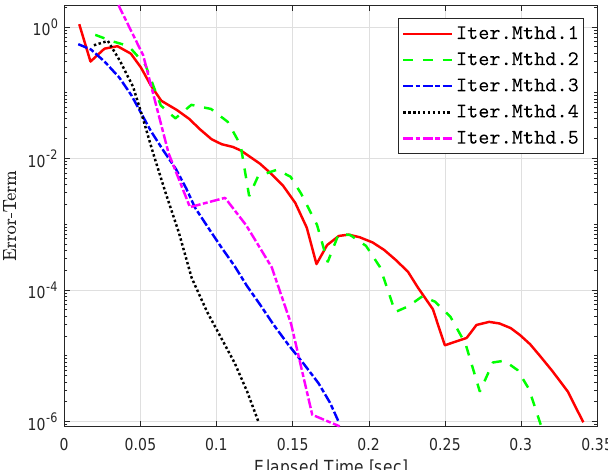
Figure 10. All techniques are computationally examined while s 0 = ( 1, − 1,2,0,3 ) T .